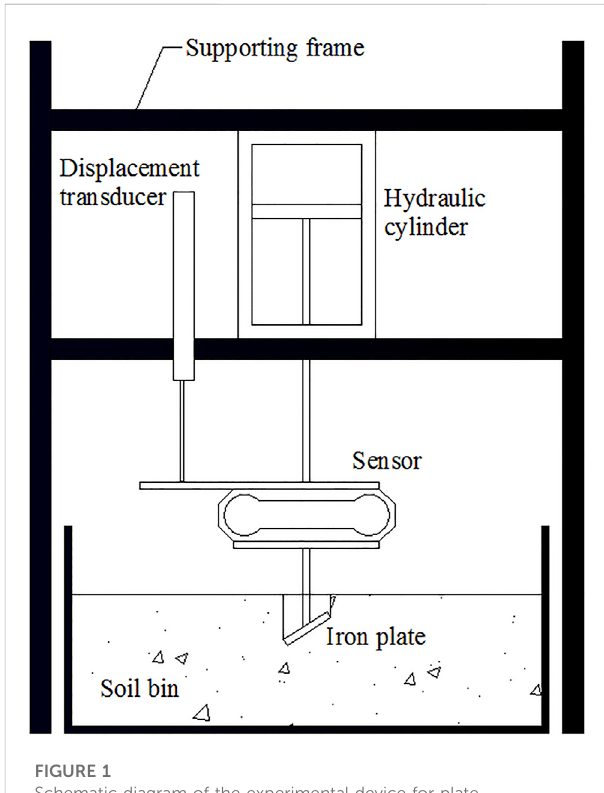
FIGURE 1 Schematic diagram of the experimental device for plate penetration